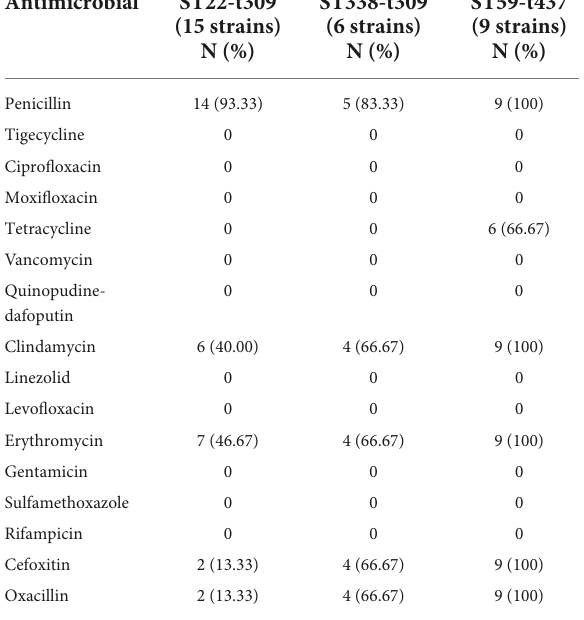
TABLE 6 Antimicrobial resistance rates of ST22-t309, ST338-t437, and ST59-t437. Antimicrobial